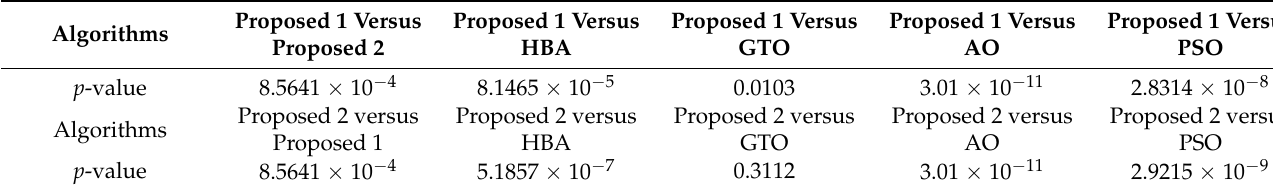
Table 8. Wilcoxon rank-sum test.